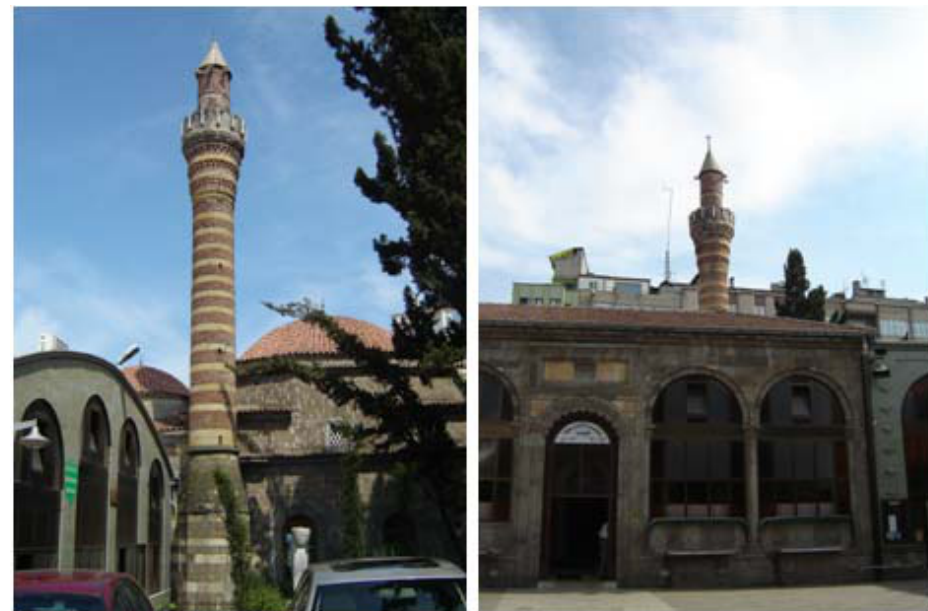
Fig. 1. Some views of ˙Iskenderpas¸, a historical masonry minaret walls were constructed for testing long-term deflections out- of-plane. Mosallam (2007) presented the results of a study focused on evaluating the out-of-plane flexural behavior of two FRP composite systems for strengthening unreinforced red brick masonry walls. Ghosh and Karbhari (2007) pro- vided details of an investigation into the strengthening effi- ciency of FRP- rehabilitated bridge deck slabs through tests conducted on slab sections cut from a bridge just prior to demolition. Al-Saidy et al. (2008) conducted an analytical parametric study on the behavior of steel-concrete compos- ite beam that has been strengthened with CFRP plates. In addition, the effect of girder damage on the overall load dis- tribution of a typical short span composite bridge has been investigated for various load cases. Mortazaei et al. (2010) determine the seismic response of FRP strengthened typi- cal existing RC buildings subjected to near-fault ground mo- tions. Kim and Harries (2010) emerged a modeling approach to predict the behavior of timber beams strengthened with FRP composites. A 3-D finite element analysis model is for- mulated, based on the orthotropic constitutive characteristics of timber species. Zaki (2011) studied the behavior of FRP strengthened circular columns under combined axial loads series of laboratory tests investigating the behavior of a large model masonry arch bridge repaired with externally bonded FRP composites on its intrados. A two-span, single-ring semi-circular brick arch bridge was selected for this study, complete with fill material. Besides these studies, there is not more paper exist only a few paper (not enough for liter- ature) exist relate to dynamic responses of FRP strengthened thin and tall historical masonry structures such as